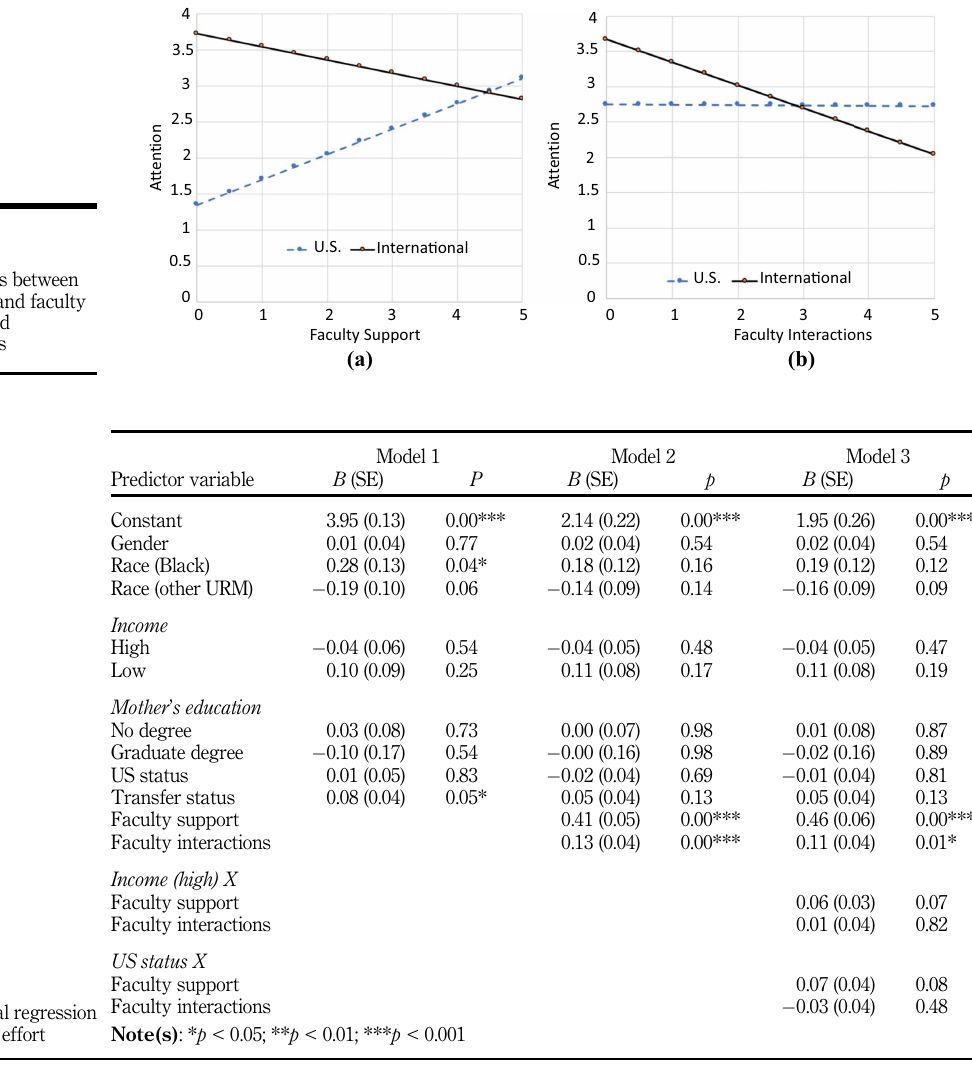
Figure 2. Interactions between US status and faculty support and interactions